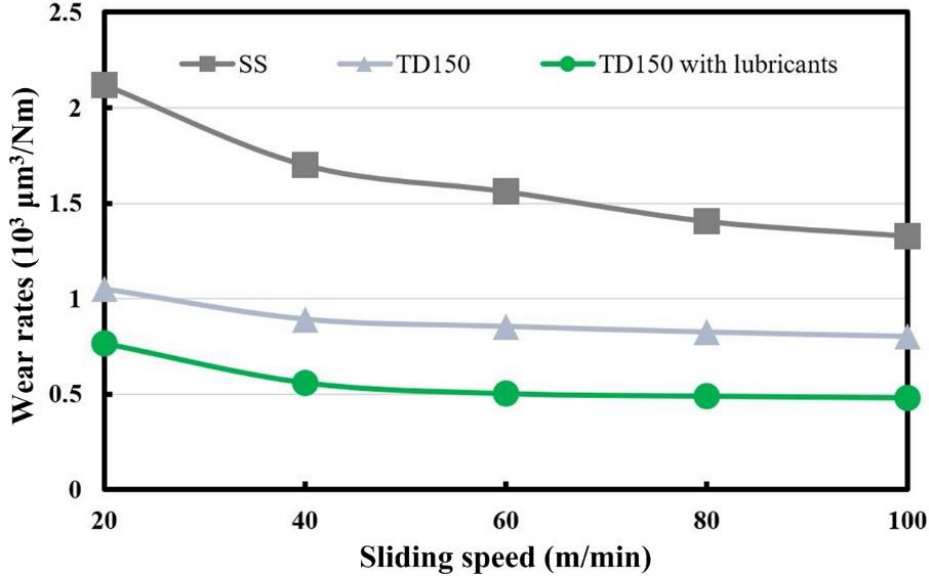
Figure 10. Wear rates of the worn ceramic balls sliding with different samples at different speeds.